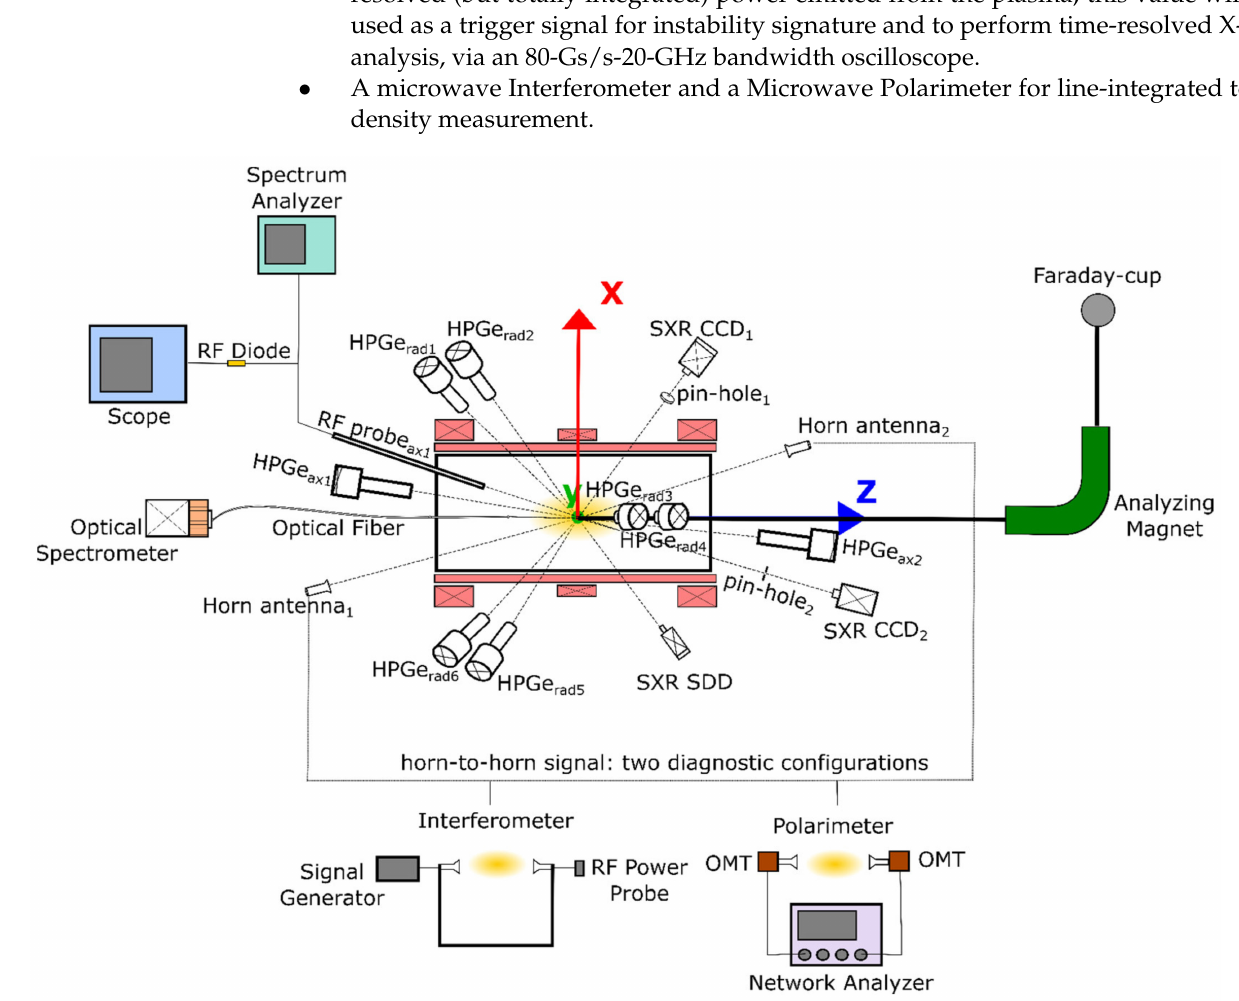
Figure 6. Pictorial sketch of the integrated set of PANDORA diagnostics, highlighting the detec- tors for X-ray spectroscopy and imaging, optical emission spectroscopy, and microwave imaging and